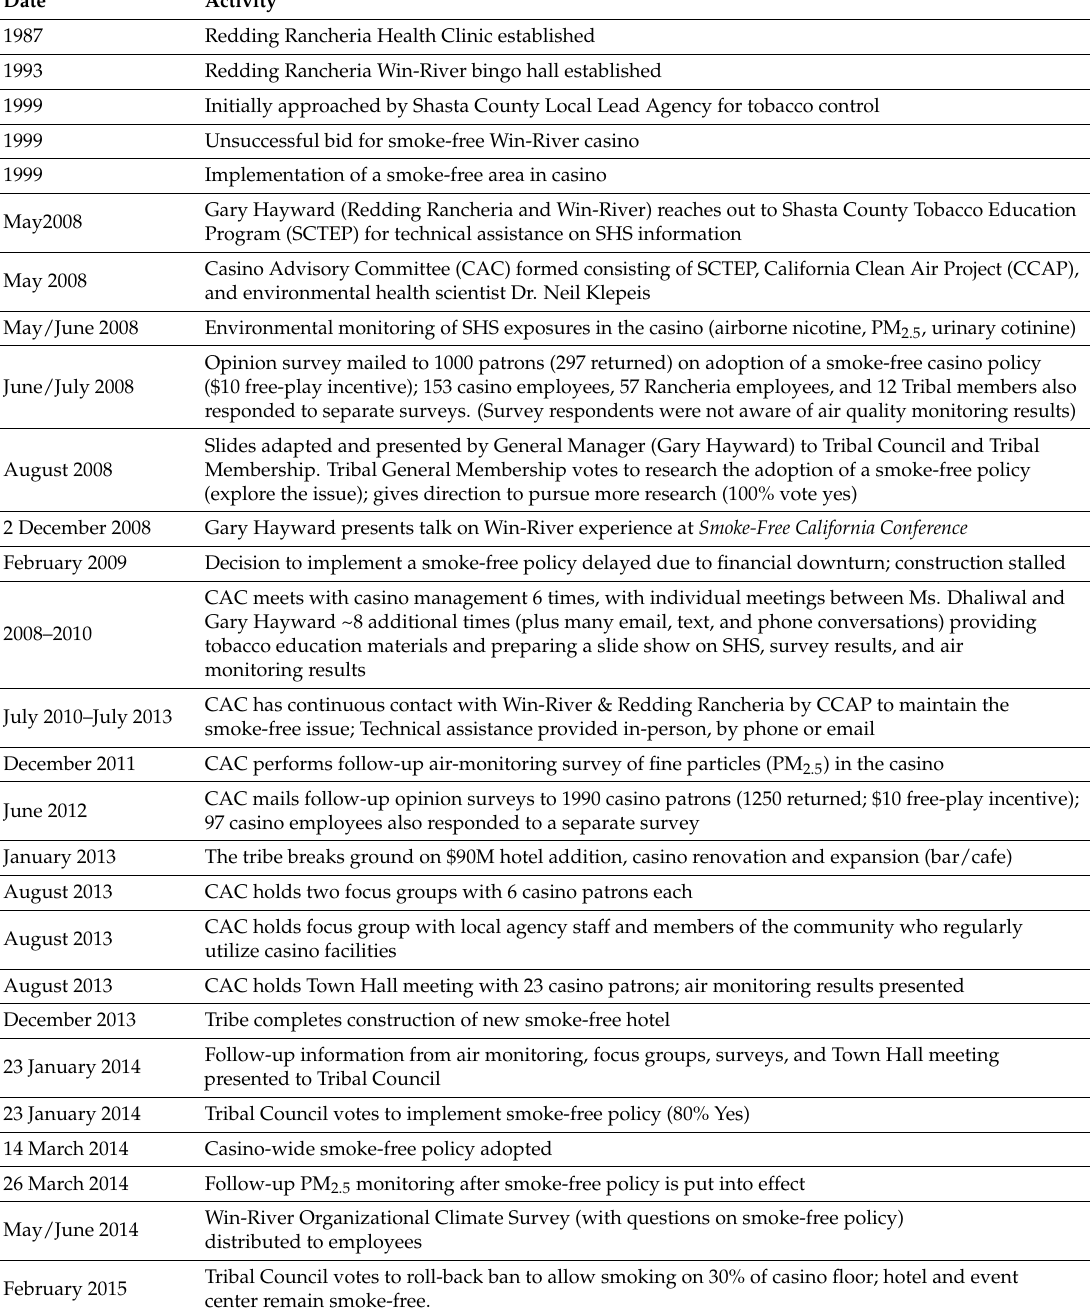
Table S1. Historical time-line of Win-River and smoke-free policy-consideration